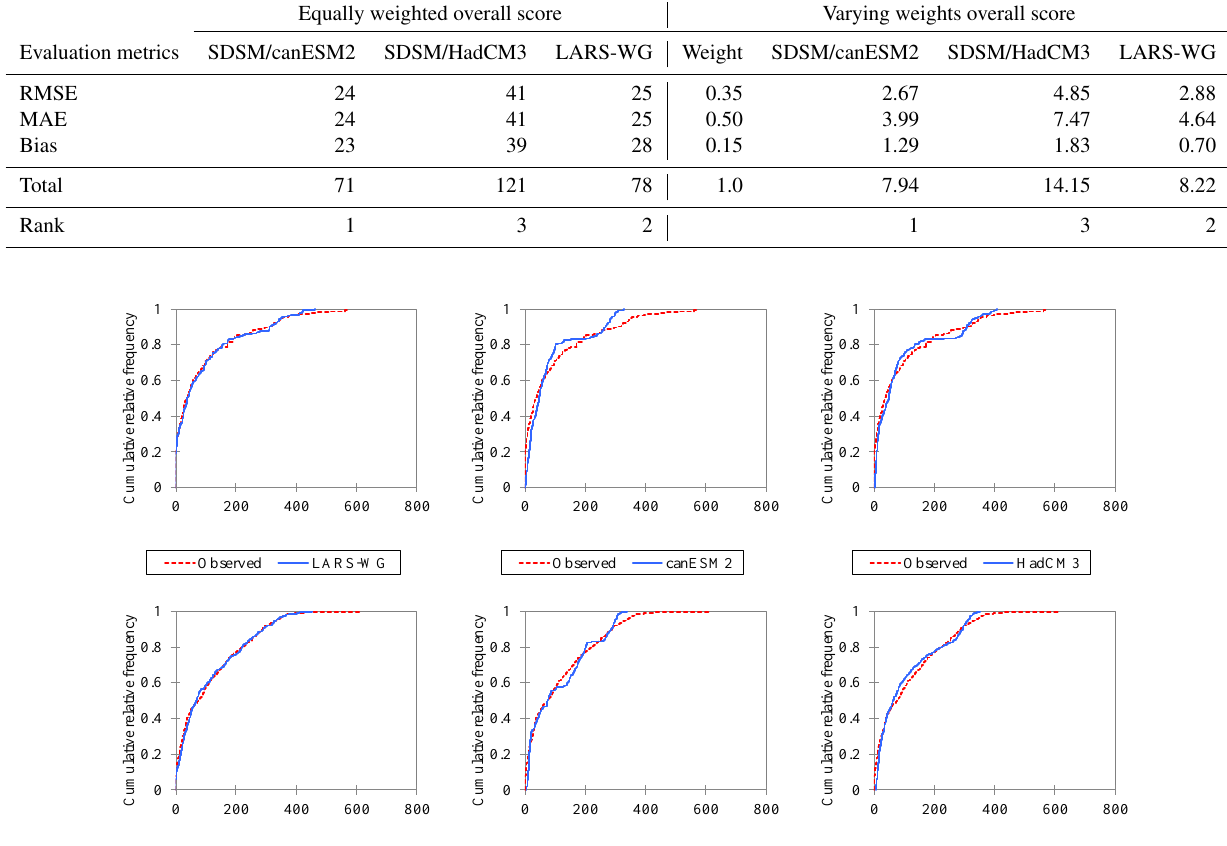
Table 5. Statistical downscaling models ranking during the baseline period (1984–2011) for quantitative measures. The numbers in the table show the total ranking scores summed up from 15 stations.